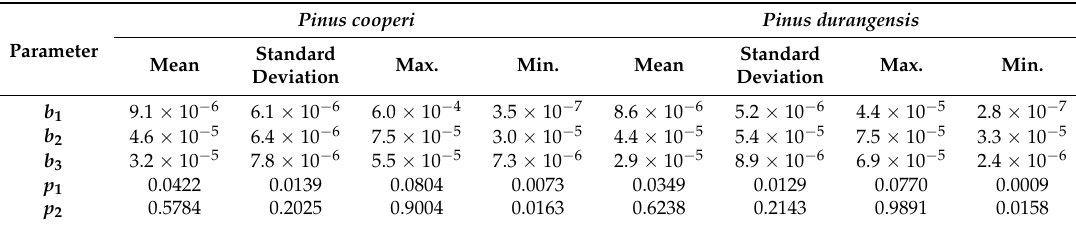
Table 4. Summary statistics of the estimated parameters for simultaneous fitting of Equations (1), (2), (4) and (5) for each tree